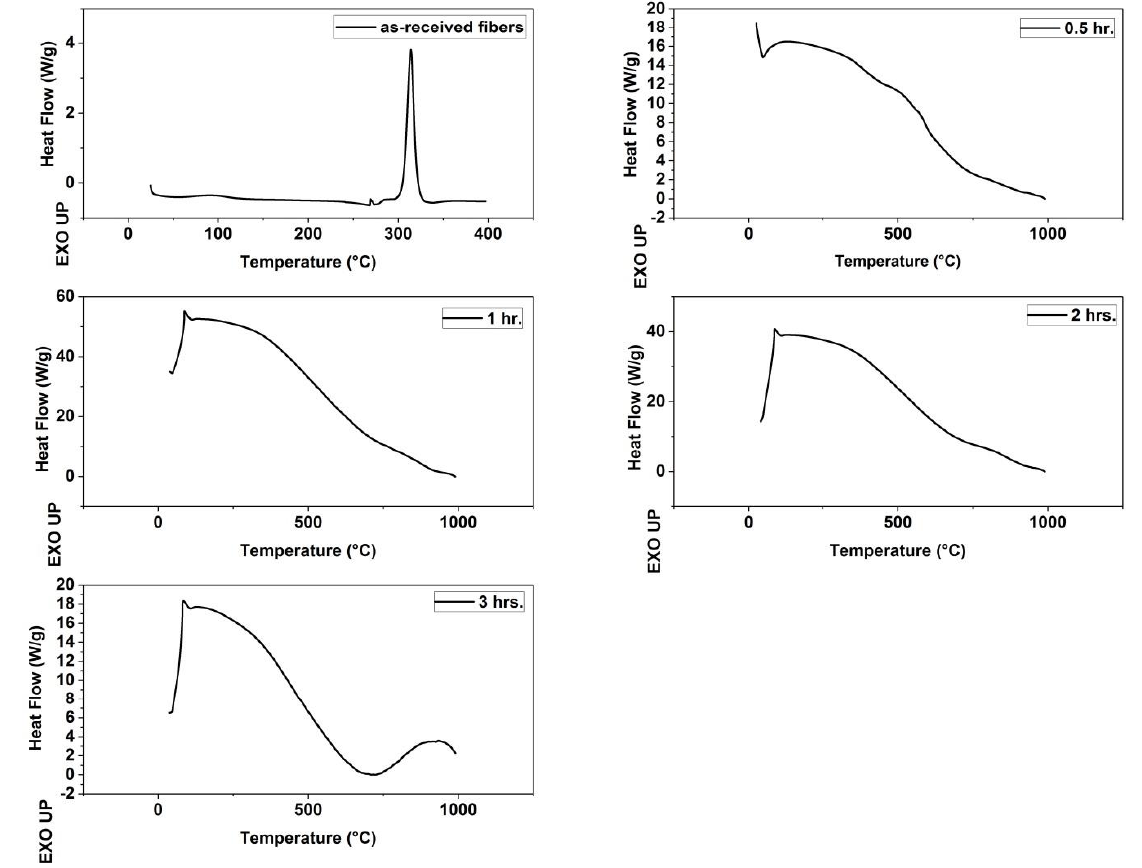
Figure 4. Differential scanning calorimetry (DSC) Thermograms of (as-received fibers, fibers stabilized for 0.5 h, fibers stabilized for 1 h, fibers stabilized for 2 h and fibers stabilized for 3 h).